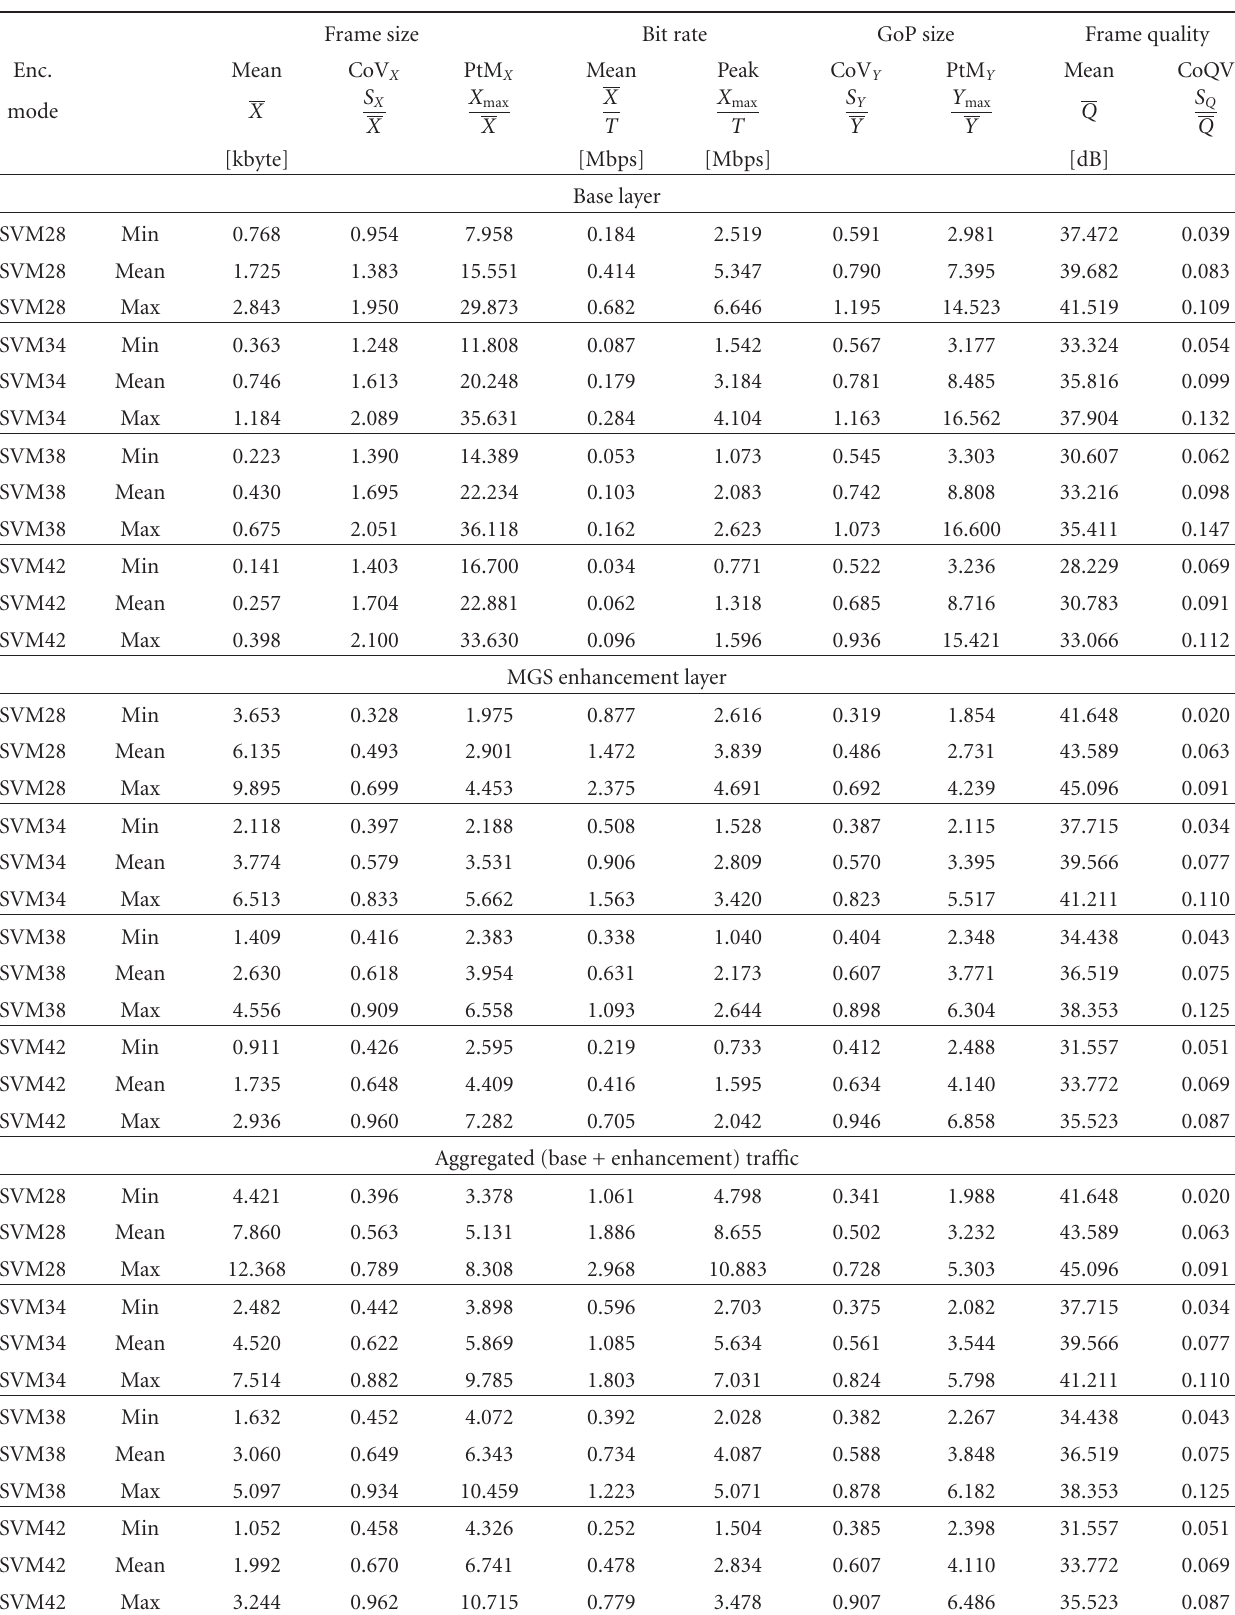
Table 8: Tra ffi c statistics for base, and enhancement layers, and aggregated tra ffi c of medium grain scalability encodings using H.264 SVC for selected quantization